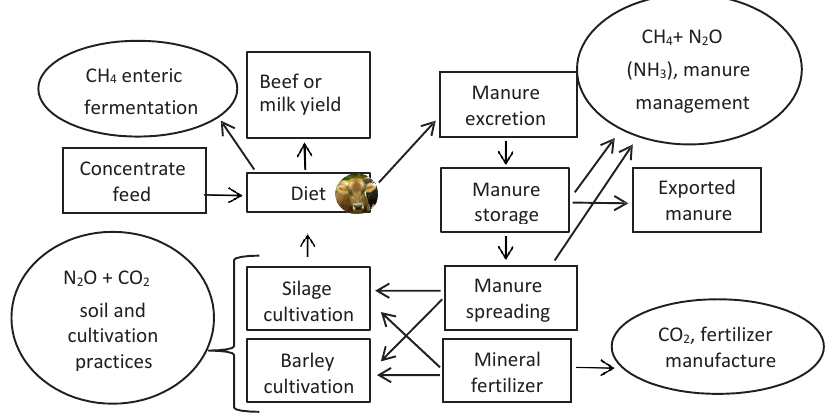
Fig. 1. Livestock production and GHG emissions. Modified from: Lötjönen et al.